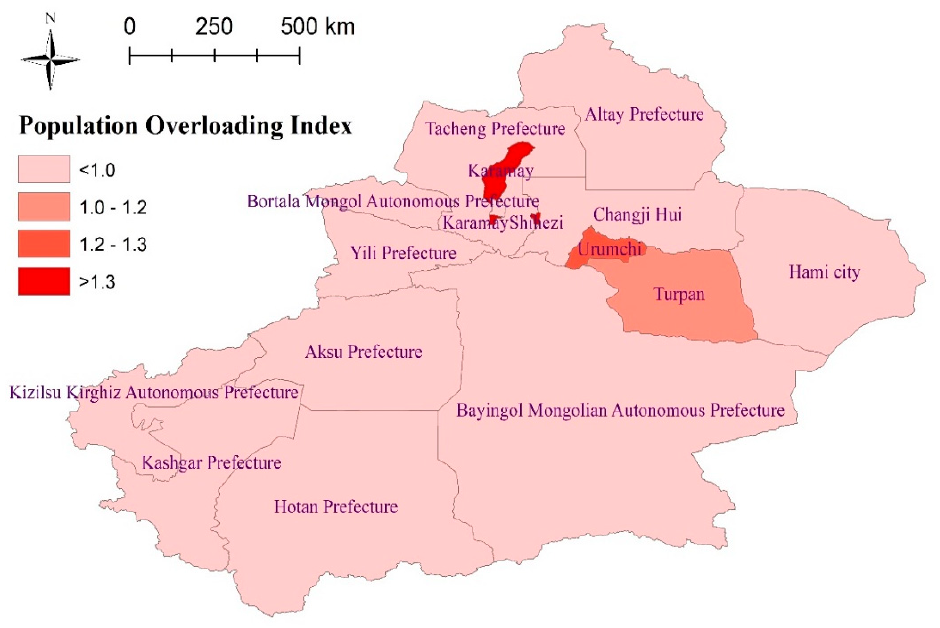
Figure 2. The Population Overloading Index of water resources carrying capacity of Xinjiang in 2018.